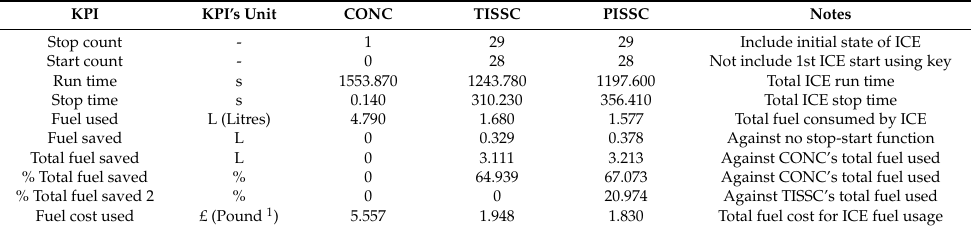
Table 6. KPI analysis for the ICE performances using different controllers after 14 cycles.